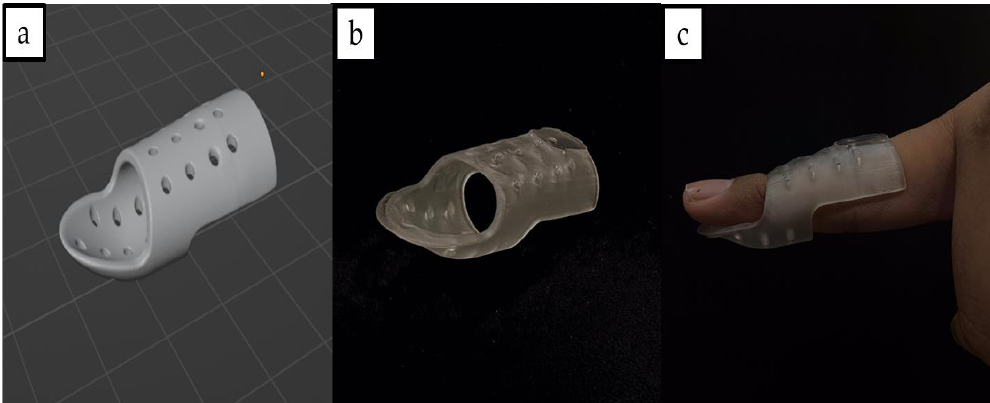
Figure 12. ( a ) Three-dimensional model design of splint; ( b ) 3D-printed splint; ( c ) 3D-printed split fitted well with the model’s finger.